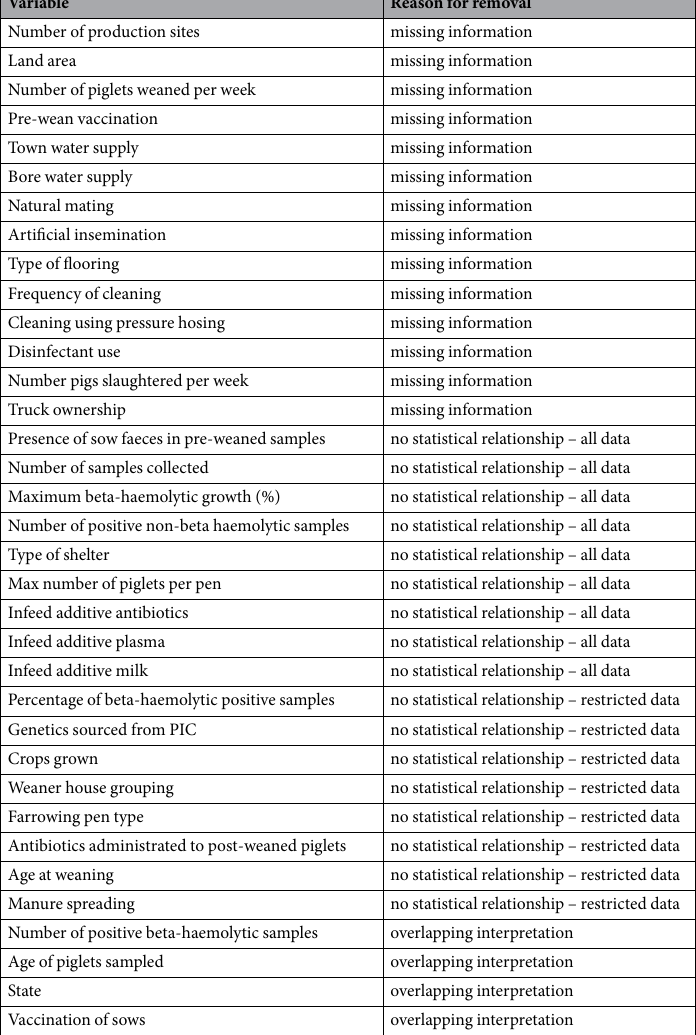
Table 2. Motivation for removing variables during analysis of a dataset describing scours in 195 pens of pigs on 22 farms in southeastern Australia: (1) due to a proportion of missing information > 5% that would reduce the power of the Bayesian network model; (2) no statistical relationship a P ≤ 0.2 with either diarrhoea or pre- or post-weaning using all available data (i.e. some variables had missing observations); (3) no statistical association as before after removing any observation that lacked data for any variable; (4) removed because of overlapping interpretation with other variables